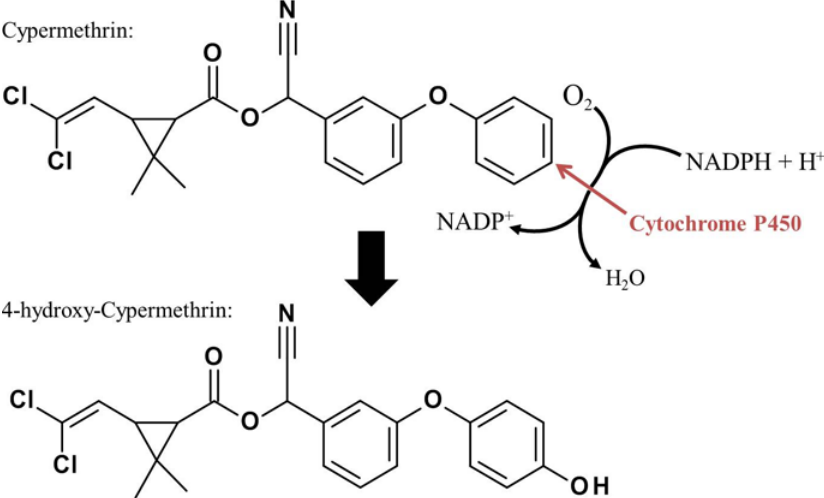
Fig 9. In pyrethroids with a phenoxybenzyl moiety, P450 enzymes catalyze the hydroxylation from, e . g ., cypermethrin to 4-hydroxy-cypermethrin. The hydroxylation reaction occurs under usage of oxygen and the cofactor